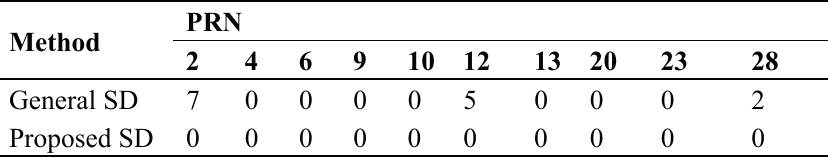
Table 13. False alarm rates.